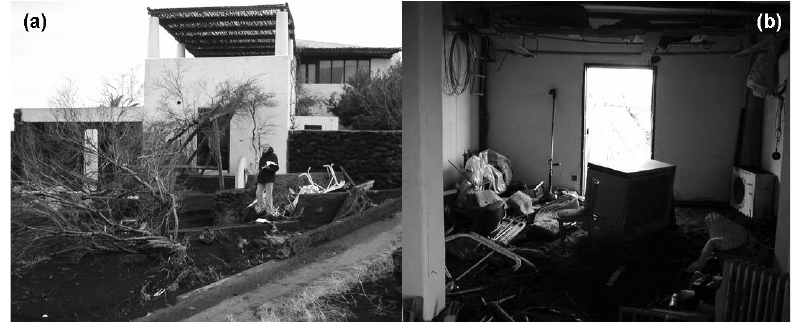
Fig. 9. Pictures of building #2, at the eastern end of Ficogrande (Stromboli – Fig. 5), taken after the 2002 tsunami. (a) A view of the building from north-west. (b) Damage to the interior. The PTVA-3 Model classified building #2 as having an “average” RVI score.